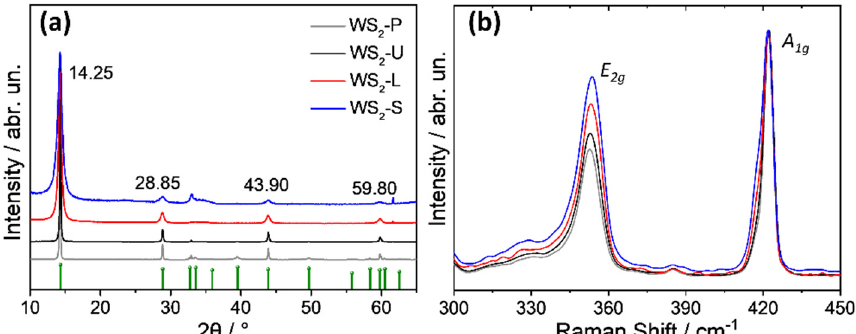
Figure 2. ( a ) XRD patterns and ( b ) Raman spectra of WS 2 -P (grey line), WS 2 -U (black line), WS 2 -L (red line), and WS 2 -S (blue line). The green marks at the bottom of ( a ) are the diffraction peaks of 2H-WS 2 (PDF Card ICDD No. 00-008-0237).